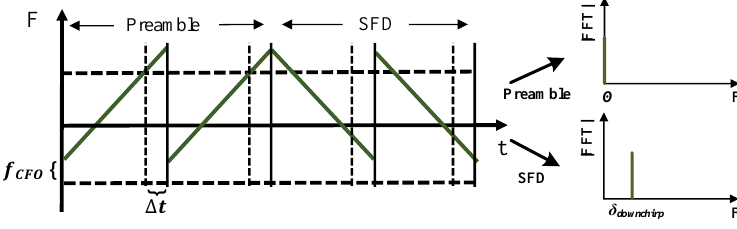
Figure 6. Example of carrier frequency offset and sampling time